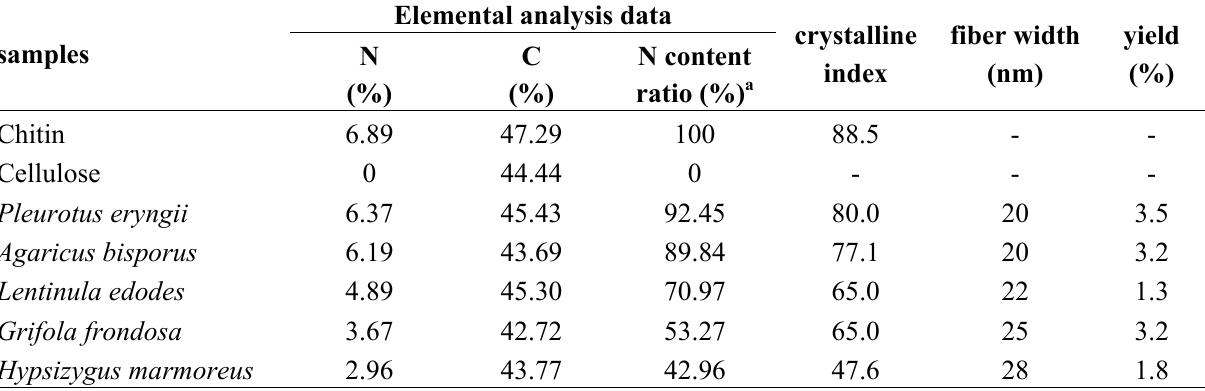
Table 1. Elemental analysis data, crystalline index, fiber width, and yield of chitin nanofibers.